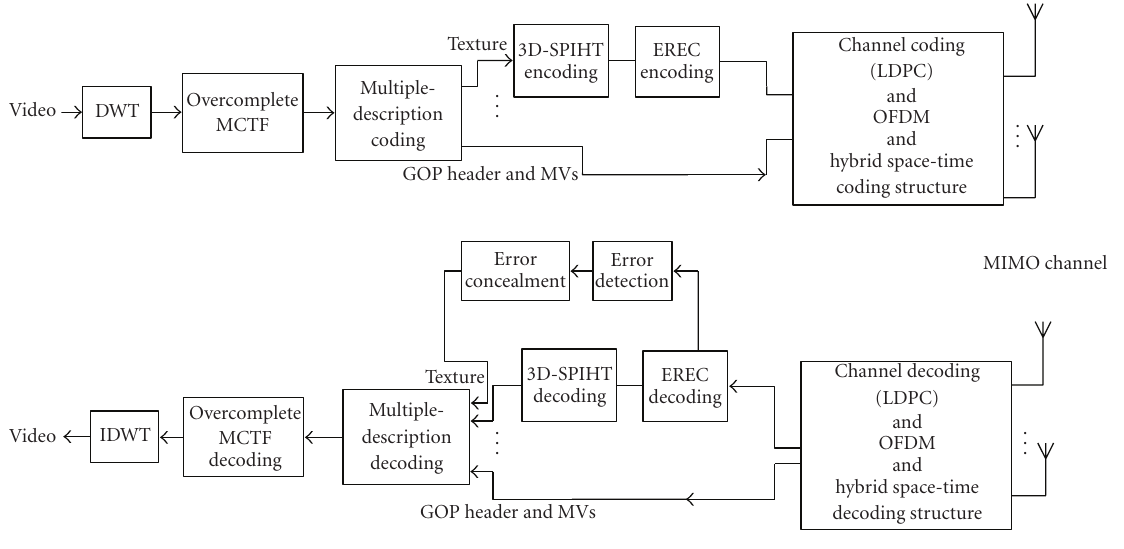
Figure 1: The overall block diagram of the proposed